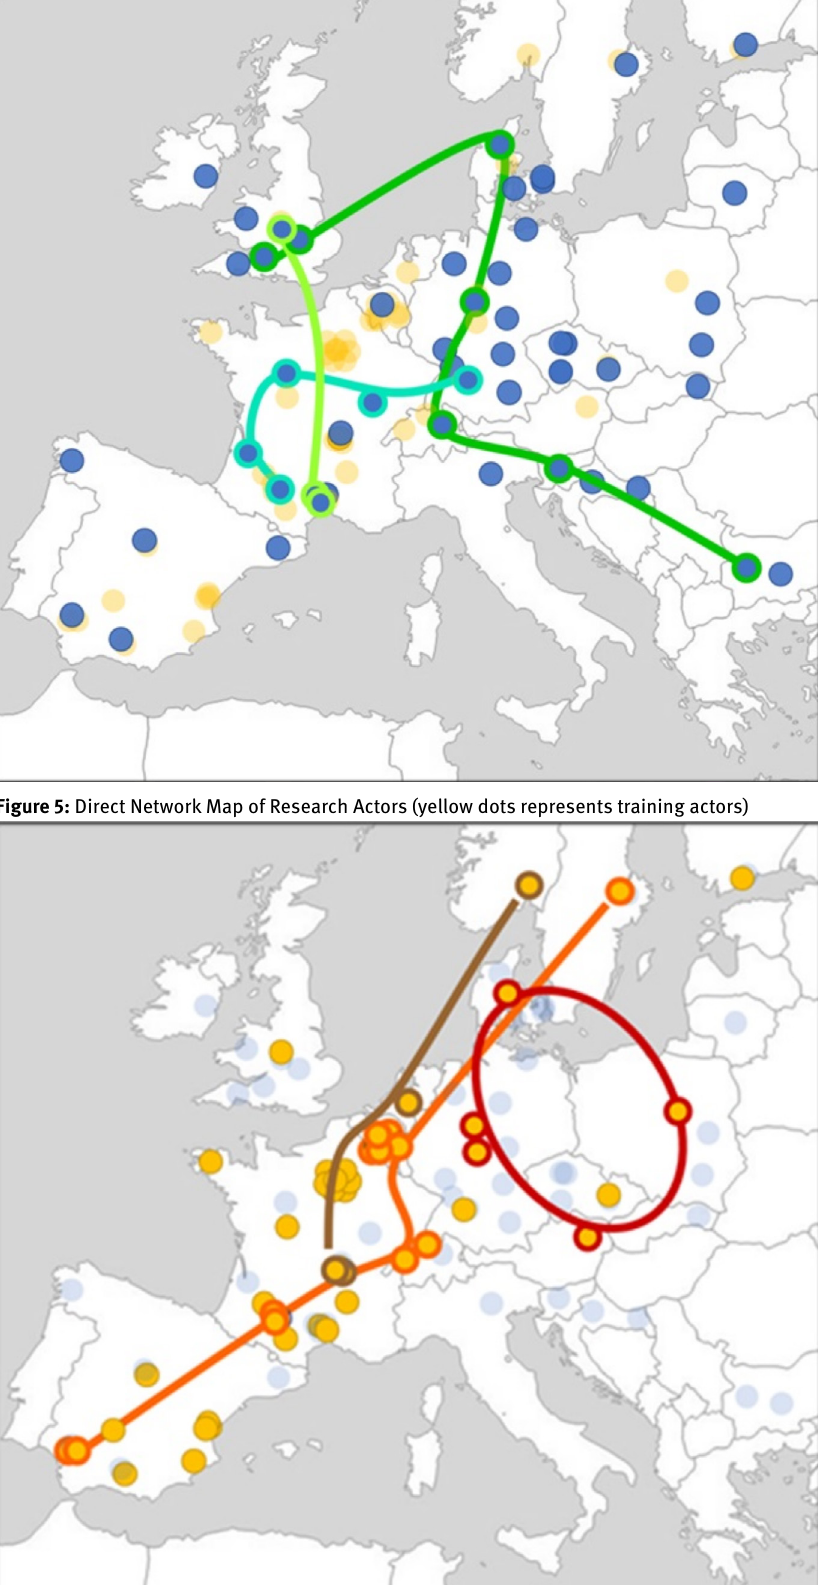
Figure 6: Direct networks map of training actors (blue dots represent research